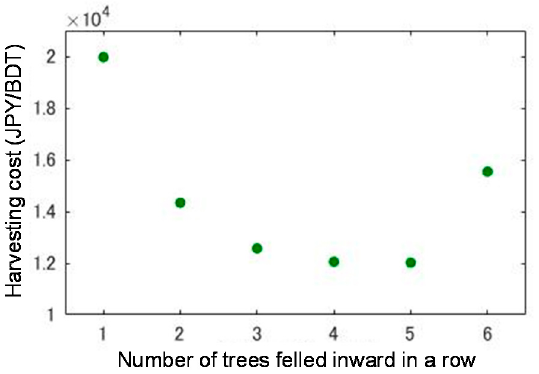
Figure 6. Relationship between the number of trees felled inward in a row and the harvesting cost.